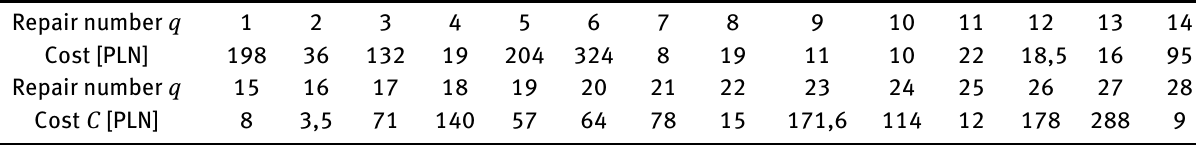
Table 6: Cost of proposed repairs for the building expressed in thousands PLN. Repair number